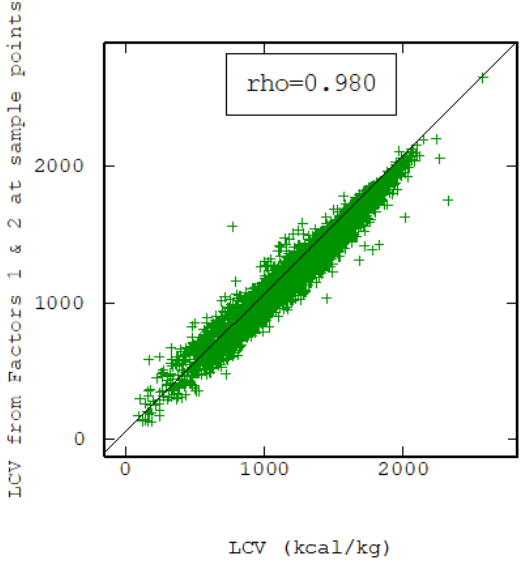
Figure 18. Scatter plot of measured vs. estimated LCV with PCA.